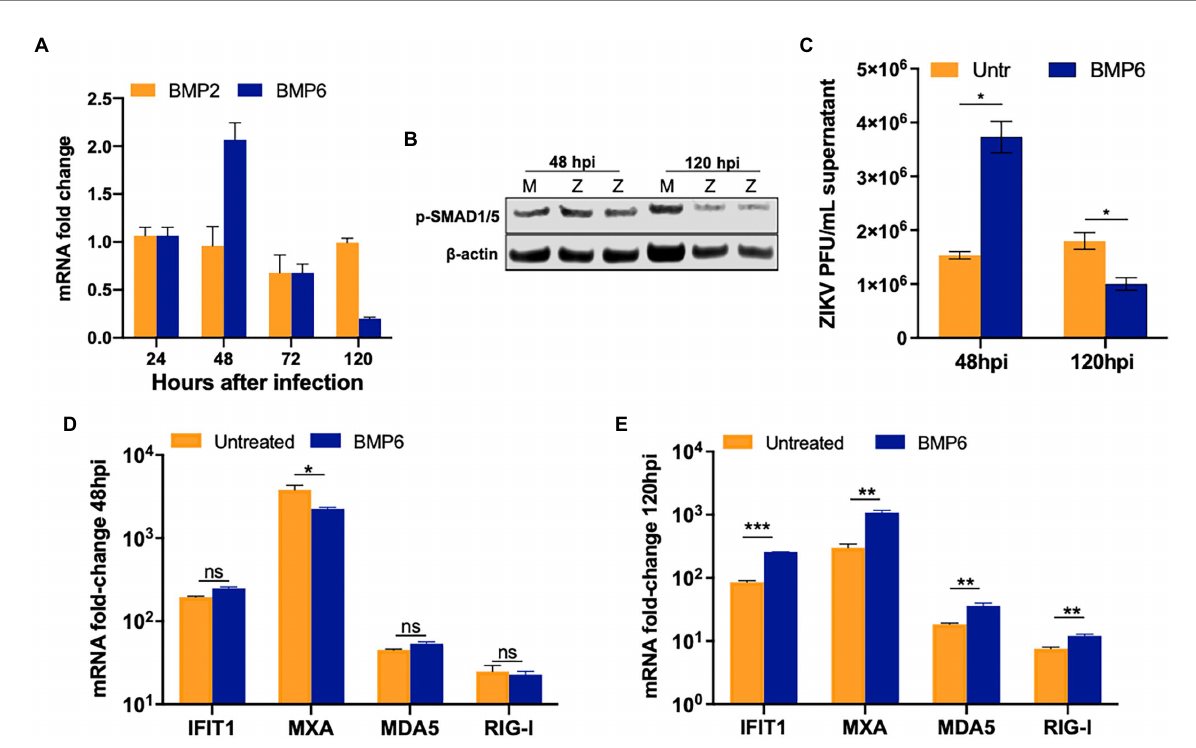
FIGURE 6 ZIKV replication impairs BMP6 signaling in SC. (A) BMP2 and BMP6 mRNA fold-change measured in SC infected with ZIKV at MOI 1. (B) Western blot analysis of phosphorylated SMAD1/5 (pSMAD1/5) at different time points after infection, β -actin was used as housekeeping loading control; each lane represents an independent experiment. (C) SC were pretreated with 100 ng/mL exogenous human recombinant BMP6 24 h before ZIKV infection at MOI 1, replenished every 24 h, and virus titers in the supernatant were assayed by plaque assay at 48 hpi. Gene expression of IFIT1, MXA, MDA5 , and RIG-I were measured using qRT-PCR at (D) 48 hpi and (E) 120 hpi, and fold change was calculated as compared to mock- infected cells after normalizing to GAPDH. Data is presented as mean ± SEM from at least 3–5 independent experiments. * p < 0.05; ** p < 0.01; *** p <